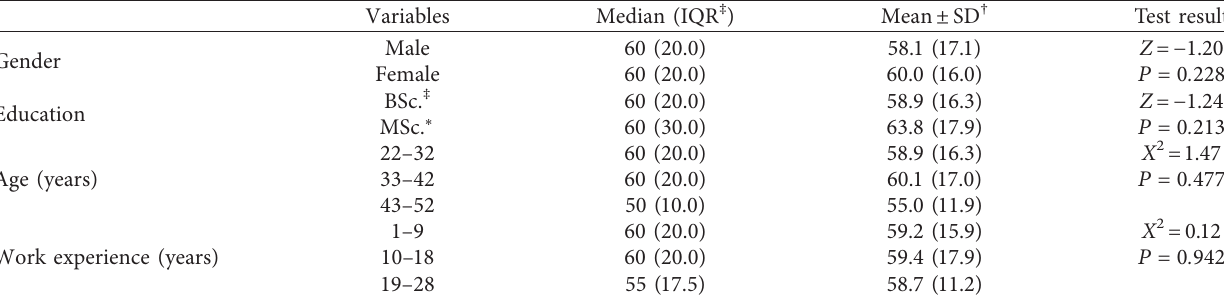
Table 3: Relationship between nurses’ knowledge of toothbrush maintenance and use and demographic variables.